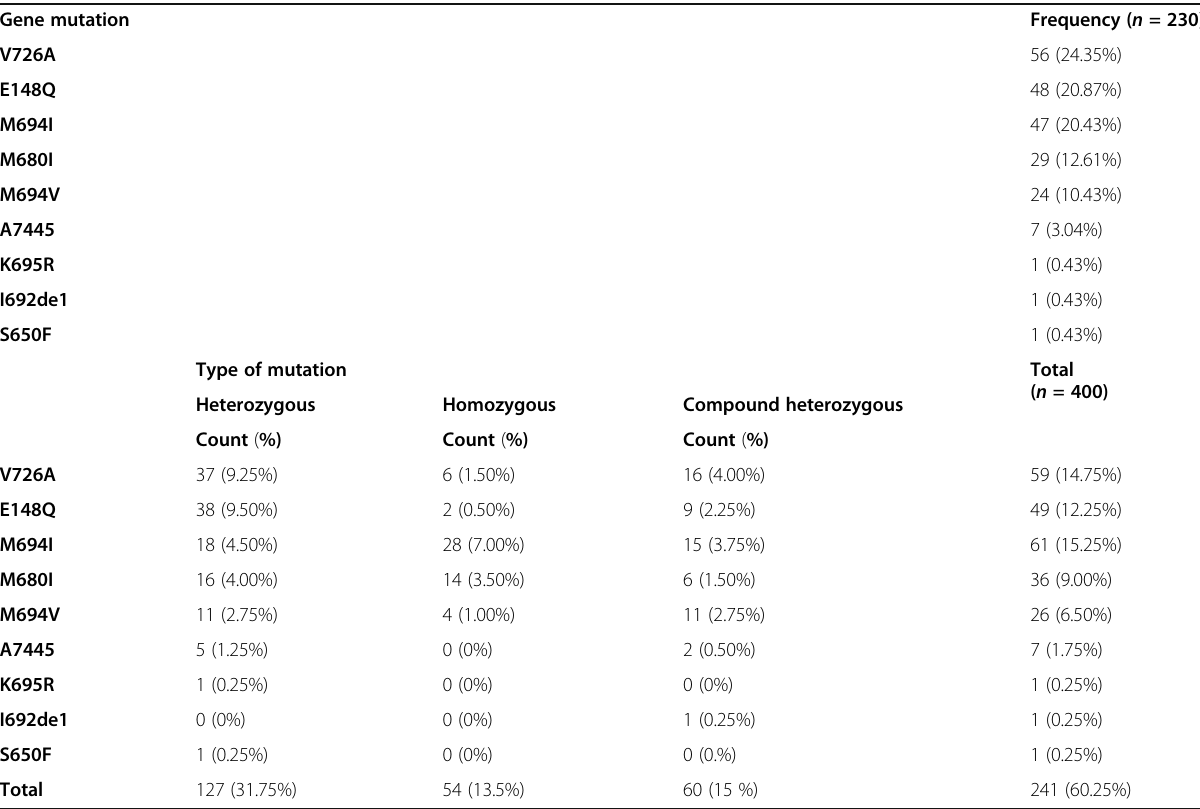
Table 2 Type of MEFV gene mutation of included FMF patients (n-230), pattern, and type of gene mutation according to gene